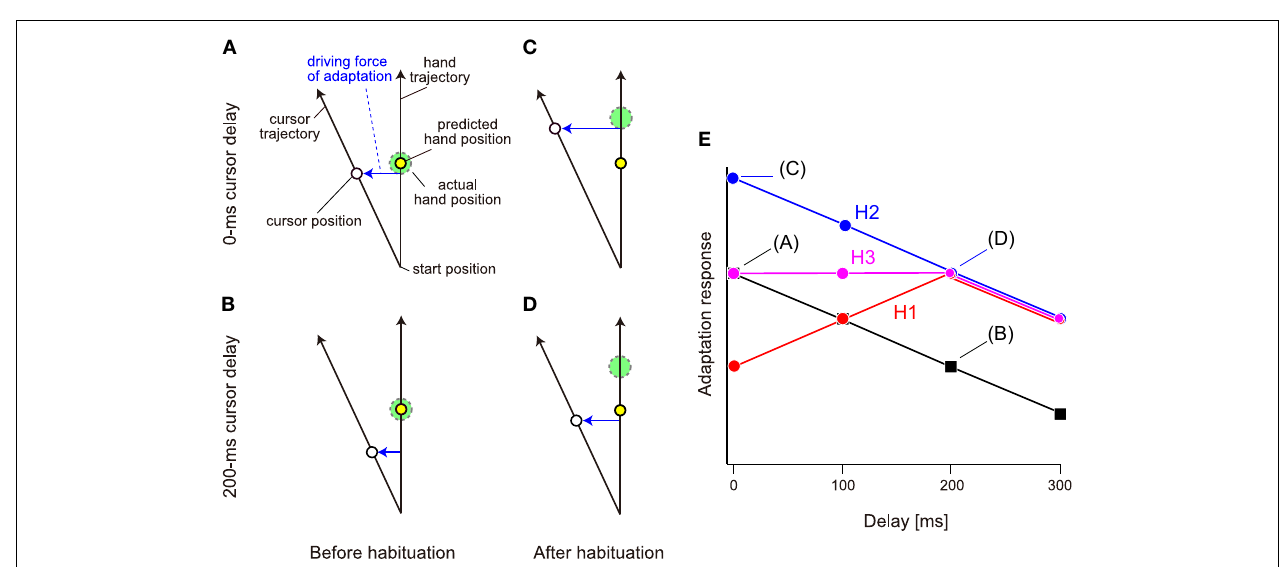
200ms delay (D) and it rather increases when the cursor is displayed with no-delay (C) . (E) When no visual feedback delay is introduced, the adaptation response to the visual rotation provided with a certain delay should gradually decrease with the increase in delay.Three hypotheses predict different patterns of adaptation response after habituation to a visual feedback delay of 200ms. Hypothesis H1 predicts the response is maximal at 200ms delay (red), while the H2 predicts the response has a monotonically decreasing function (blue), and H3 predicts an intermediate response of H1 and H2